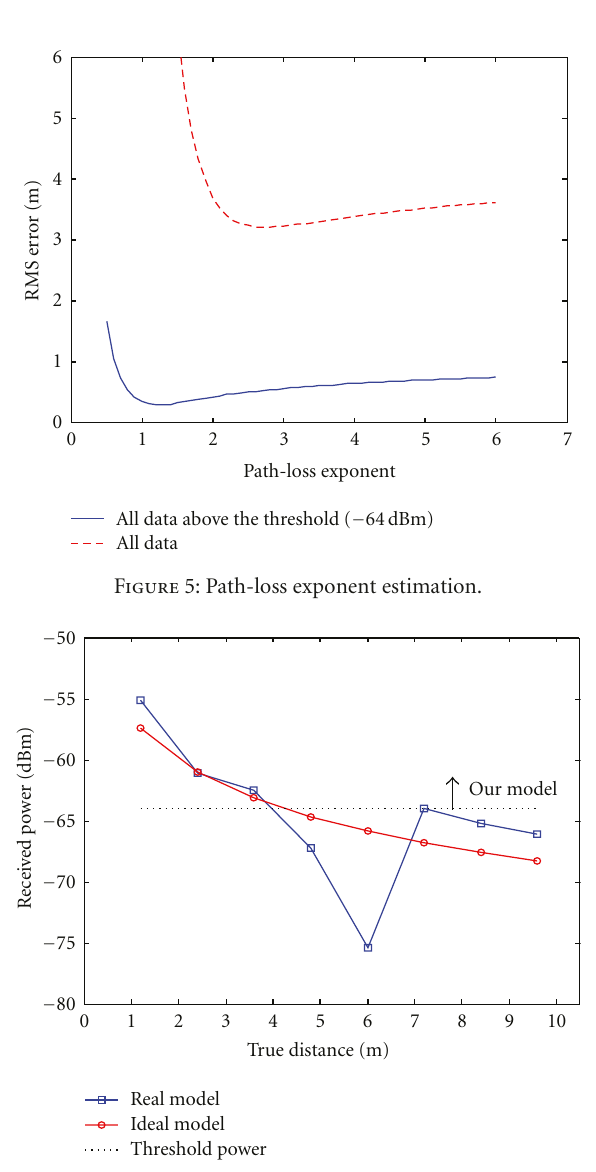
Figure 6: Reliable model for distance estimation.